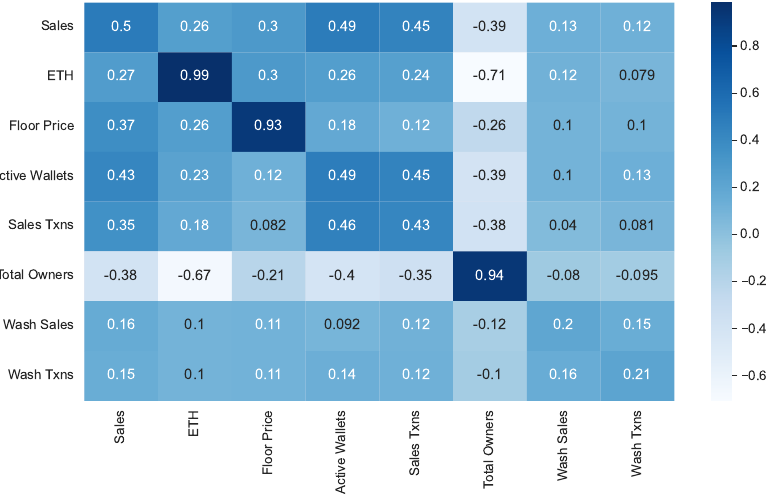
Figure 3. Cross-correlation values averaged on all available NFT collections ( h = 1).